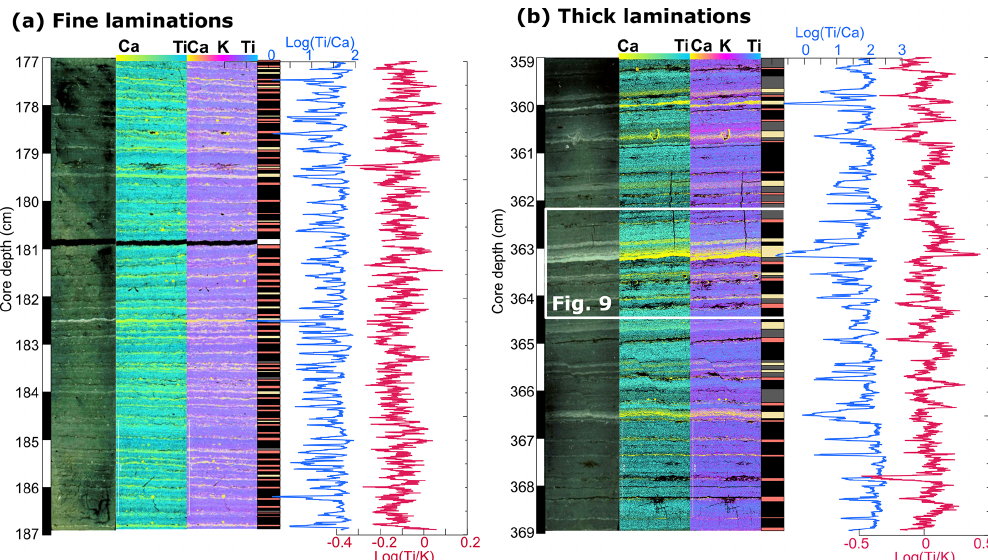
Figure 4. Laminations in core P33. (a) Fine laminations and (b) thick laminations from sections located at ca. 180 and 360cm core depth, respectively. From left to right: core depth (cm), cross-polarized scan of the thin section, elemental mapping showing relative amounts of calcium (Ca, yellow) versus titanium (Ti, turquoise), elemental mapping showing relative amounts of calcium (Ca, yellow), potassium (K, pink) and titanium (Ti, blue), schematic lithological log with colour-coded sublayer type following Fig. 3a (LL1: pink; DL1: grey; LL2: yellow; and DL2: black), down-section profile of log (Ti / Ca) (blue) and log (Ti / K)